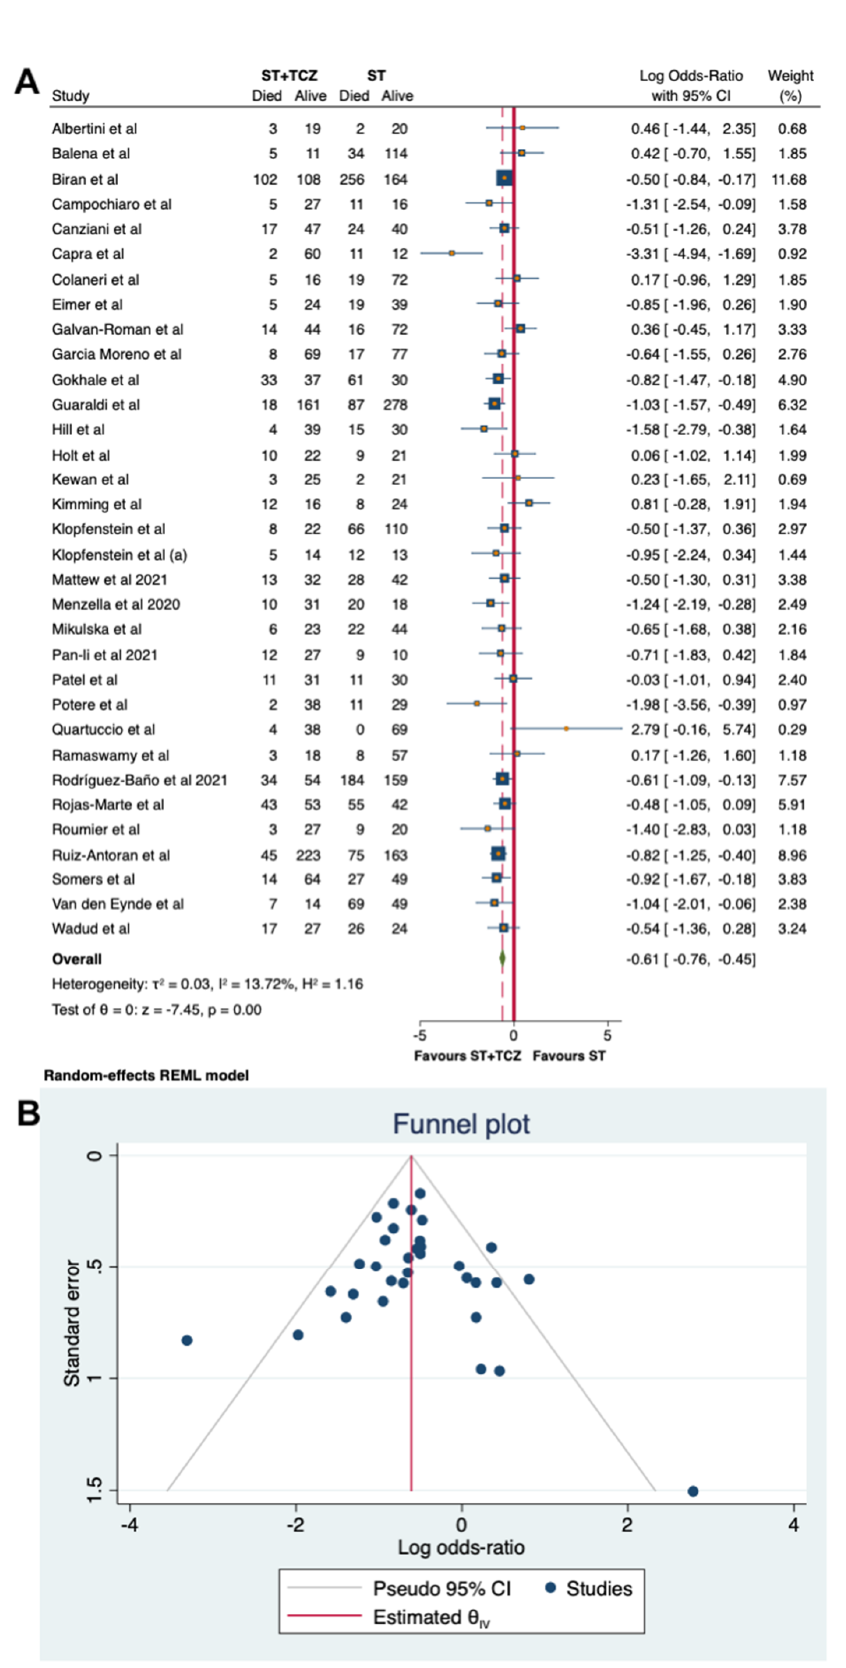
Figure 5. ( A ) Forest plot of the sensitivity analysis on observational studies by random-effects model. ( B ) Funnel plot of the sensitivity analysis on the observational studies.